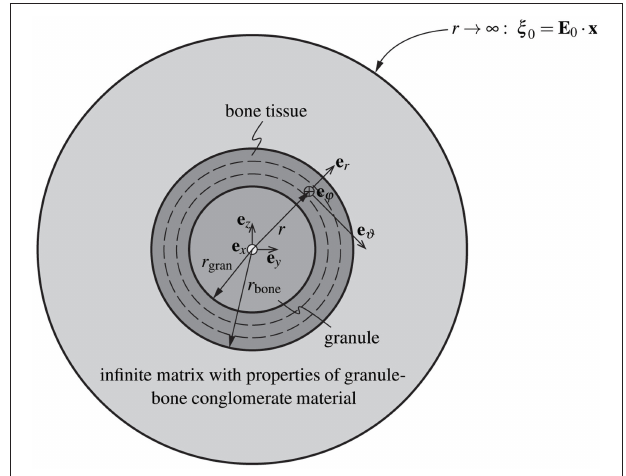
FIGURE 2 | Adaption of the model of Hervé and Zaoui (1993). Homogenization of the stiffness of the macro-porous granular scaffold material considering bone ingrowth, with spherical granules coated by bone tissue, and embedded in a polycrystal-type composite material consisting of the bone-coated granules and